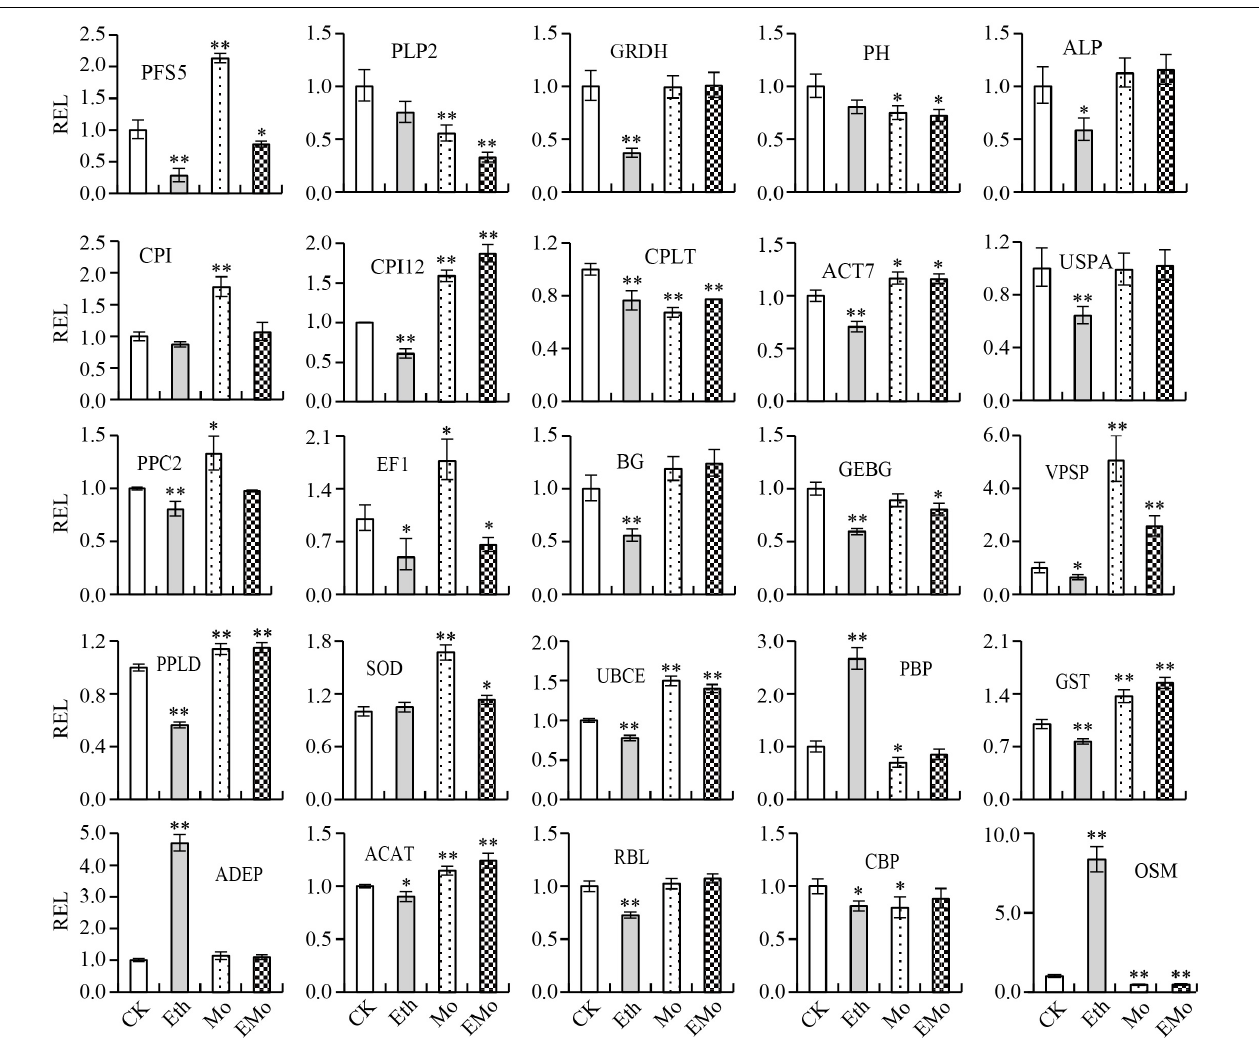
FIGURE 6 | Gene expression analysis of the typical proteins from rubber latex. The 25 typical proteins of DEPs were performed by qRT-PCR analysis to determine their corresponding gene expression patterns. Values are the mean ± SD ( ∗ P ≤ 0.05 and ∗∗ P ≤ 0.01). REL, relative expression level; PFS5, prefoldin subunit 5; PLP2, patatin-like protein 2; GRDH, glucose and ribitol dehydrogenase; PH, pro-hevein; ALP, annexin-like protein; CPI, cysteine proteinase inhibitor; CPI12, cysteine proteinase inhibitor 12; CPLT, chlorophyllase type 0; ACT7, actin-7; USPA, universal stress protein A-like protein; PPC2, phosphoinositide phospholipase C 2; EF1, elongation factor 1-delta; BG, beta-glucosidase; GEBG, glucan endo-1,3-beta-glucosidase; VPSP, vacuolar protein sorting-associated protein 2; PPLD, phospholipase D alpha 1; SOD, superoxide dismutase; UBCE, ubiquitin-conjugating enzyme E2; PBP, pyridoxal biosynthesis protein PDX1; GST, glutathione S-transferase; ADEP, aldose 1-epimerase; ACAT, acetyl-CoA acetyltransferase; RBL, ricin B-like lectin; CBP, calcium-binding protein; OSM, osmotin. The primers used for qRT-PCR are provided in Supplementary Table S3